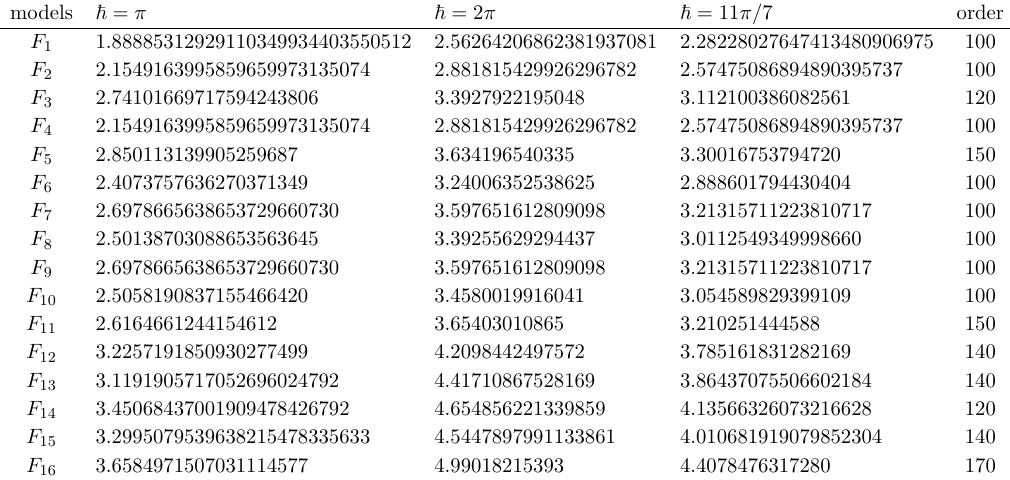
Table 4 . Borel-Pad(cid:19)e sums of the perturbative ground state energies for the models listed in table 2. The presented digits are both stable and identical with numerical results. The last column gives the orders of perturbative series used in the Borel-Pad(cid:19)e sums.